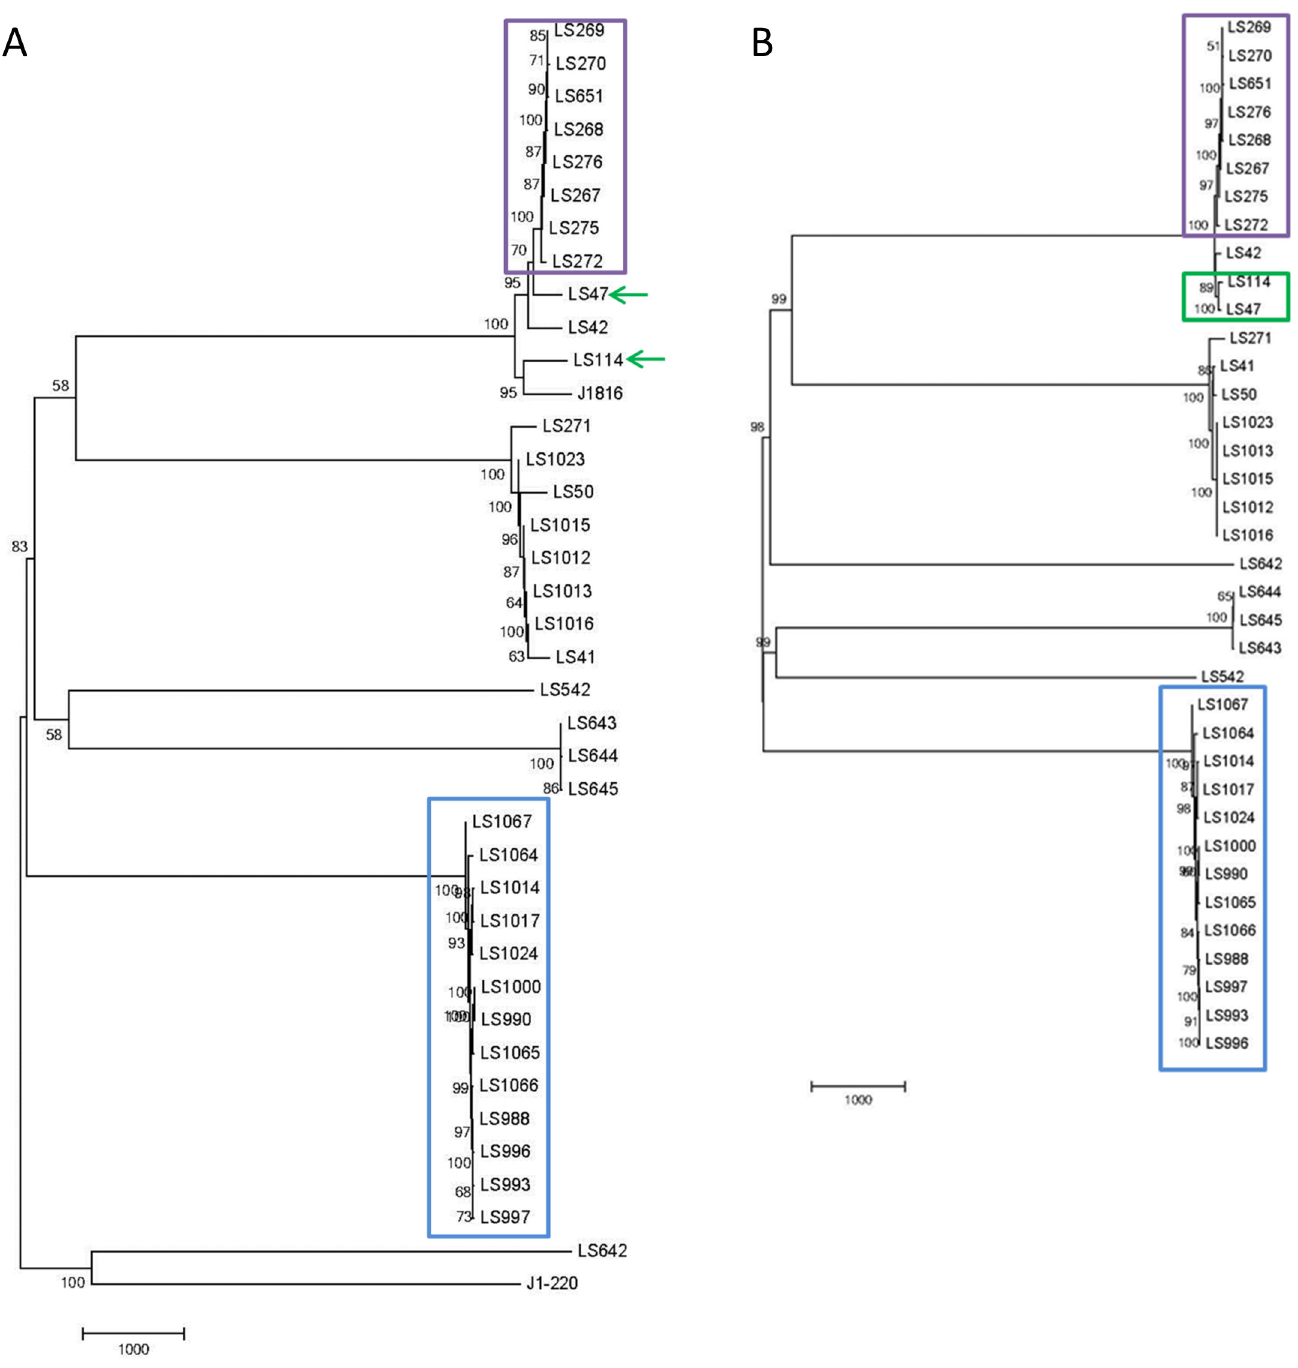
Fig 3. Neighbor-Joining trees based on the CFSAN SNP pipeline results. A) This tree shows the evolutionary relationships between the 4b and 4bV strains, using LS642 as the reference strain. B) This tree examines 4b and 4bV strains, using F2365 as the reference strain. Clusters 1, 2 and 3 are highlighted in purple, green and blue, respectively, in both. The use of arrows used in 3a show the alteration that can occur using a more distantly related reference